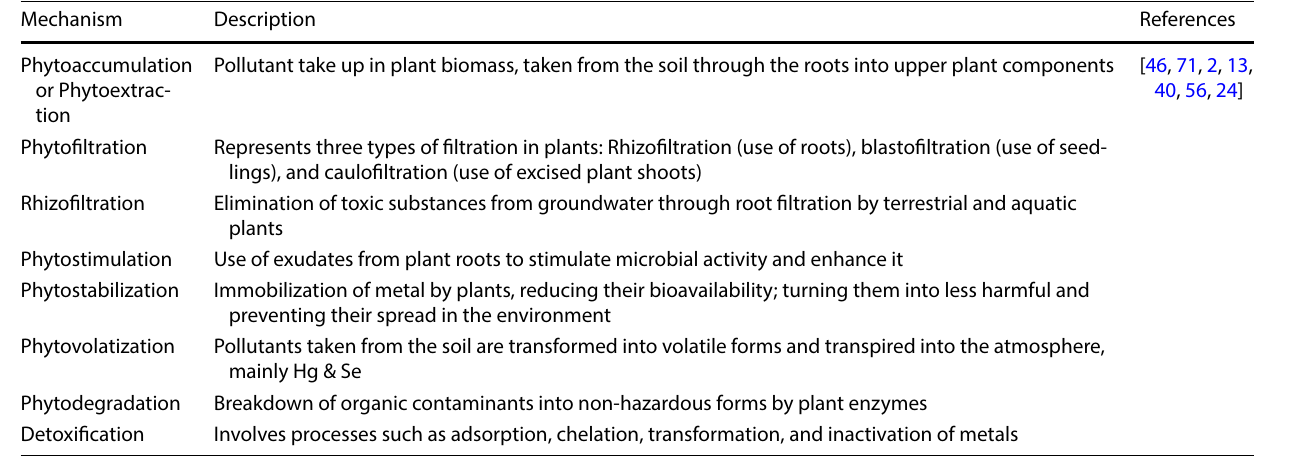
Table 2 Bioremediation mechanisms in